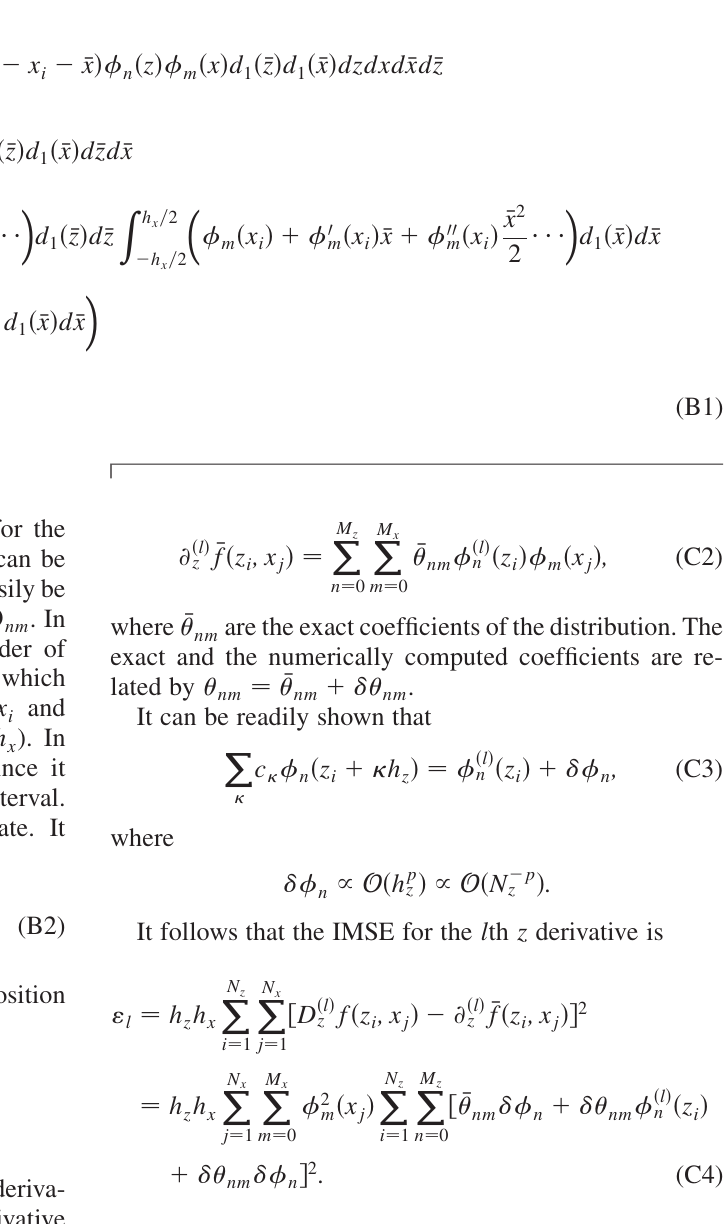
c for p th order first derivative z (cid:14)